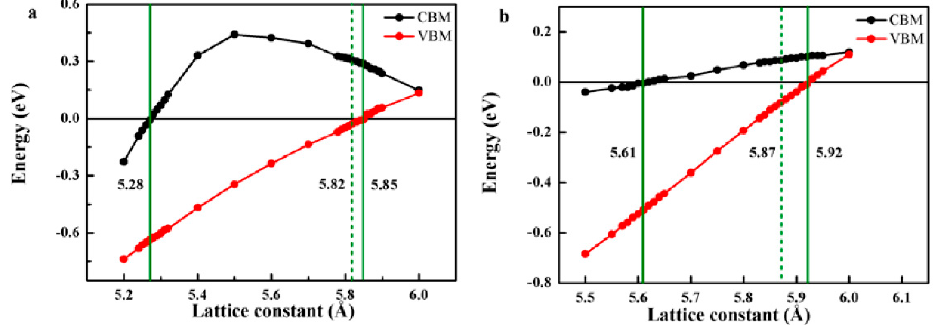
Figure 6. The conduction band minimum (CBM) and valence band maximum (VBM) in the majority spin channel as functions of lattice constants for ( a ) FeRhCrSi and ( b ) FePdCrSi compounds.